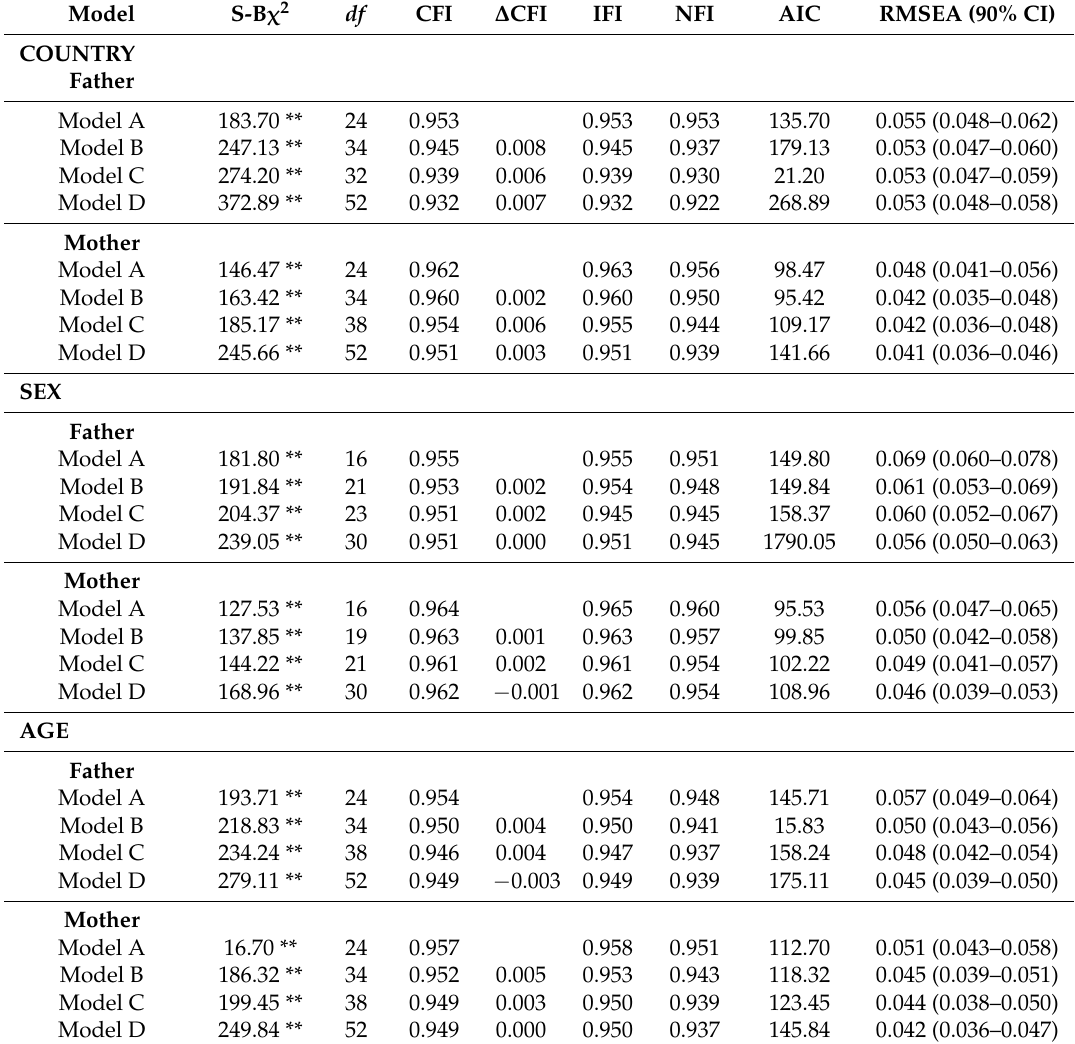
Table 3. Multi-sample analysis of invariance across country, age, and sex of fathers’ and mothers’ parenting